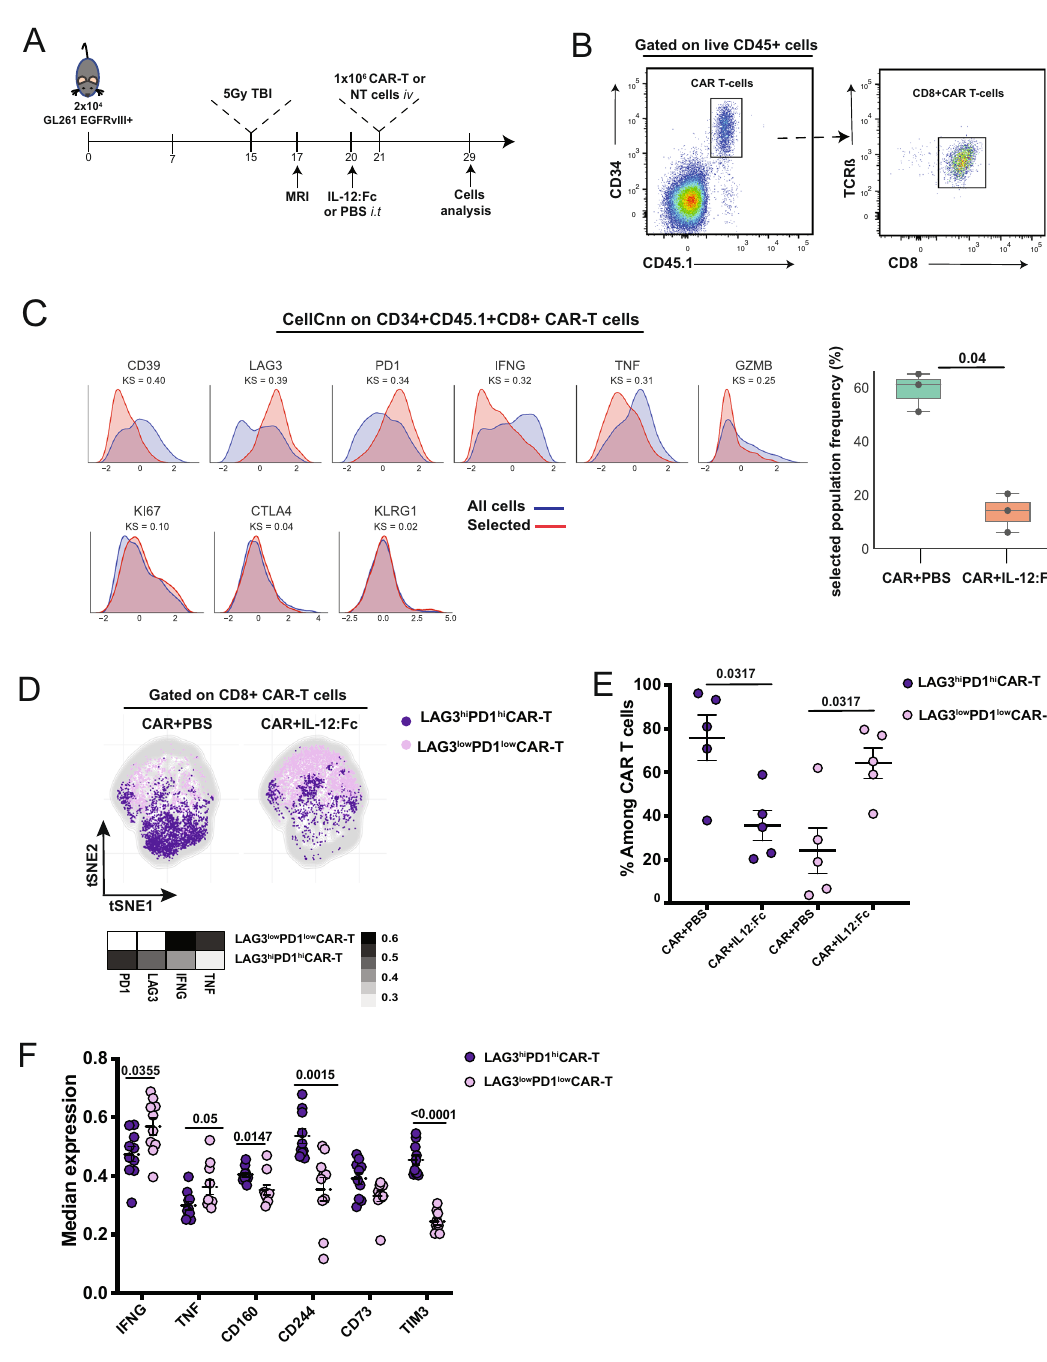
Fig. 3 Intra-tumoral IL-12:Fc administration reinvigorates EGFRvIII-speci fi c CAR-T cells. A Experiment timeline. GL261 EGFRvIII + cells were implanted in the right striatum at day 0. Mice received 5 Gy TBI on day 15 post implantation, while tumor engraftment was con fi rmed on day 17. On day 20, mice underwent surgery and received either PBS or 300 ng of IL-12:Fc at tumor site, followed by intravenous injection of 1 × 10 6 CAR-T cells or non-transduced cells. On day 29 mice were euthanized and FACS analysis was performed on recovered lymphoid cells from brain and spleen. B Manual gating of fl ow cytometry data on CAR-T de fi ned as CD45.1 + TCR- β + CD34 + CD8 + cells in a representative brain sample among glioma-bearing mice treated with CAR + IL-12:Fc. C Relative marker distributions, shown as scaled histograms of arcsinh-transformed marker expression, for all CAR-T cells (violet) and the selected population (red) by CellCNN analysis (left panel); boxplot showing the median frequency and 25 th and 75 th percentile of the selected population in CAR and CAR + IL-12:Fc group (right panel), n = 5 mice per condition, representative of n = 2 independent experiments. D t-SNE map showing the FlowSOM-guided metaclustering of live intratumoral CD8 + CAR-T cells in the different treatment groups; each color represents a metacluster and is associated with a different immune population. Heatmap showing the median marker expression in each metacluster (value range: 0 – 1, black and white). E Frequency of CD8 + CAR-T cells for each metacluster in each condition, n = 5 mice per condition, representative of n = 2 independent experiments. F Median expression of selected cell markers shown for LAG3 hi PD1 hi CAR-T cells and LAG3 low PD1 low CAR-T cells in both CAR + PBS and CAR + IL12:Fc conditions, n = 5 mice per condition, representative of n = 2 independent experiments. Data are presented as mean values ± SEM. 2-tailed unpaired Mann – Whitney T test ( C , E , F ). Source data are provided as a Source Data fi